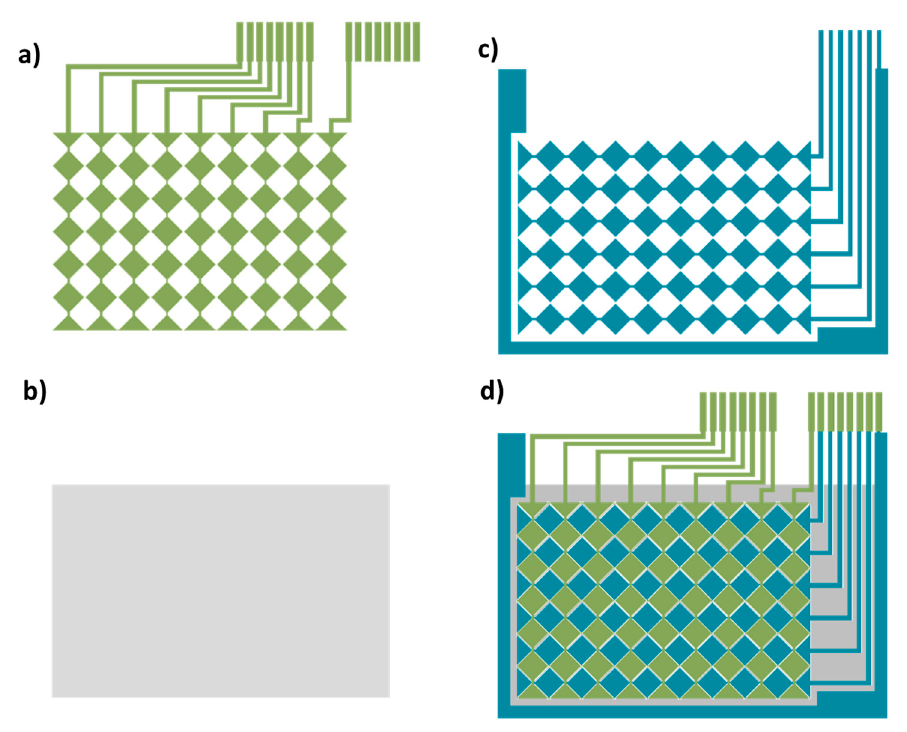
Figure 2. Two Layers Design (TLD): ( a ) Vertical or X layer; ( b ) dielectric layer; ( c ) Horizontal or Y layer; and ( d ) the complete